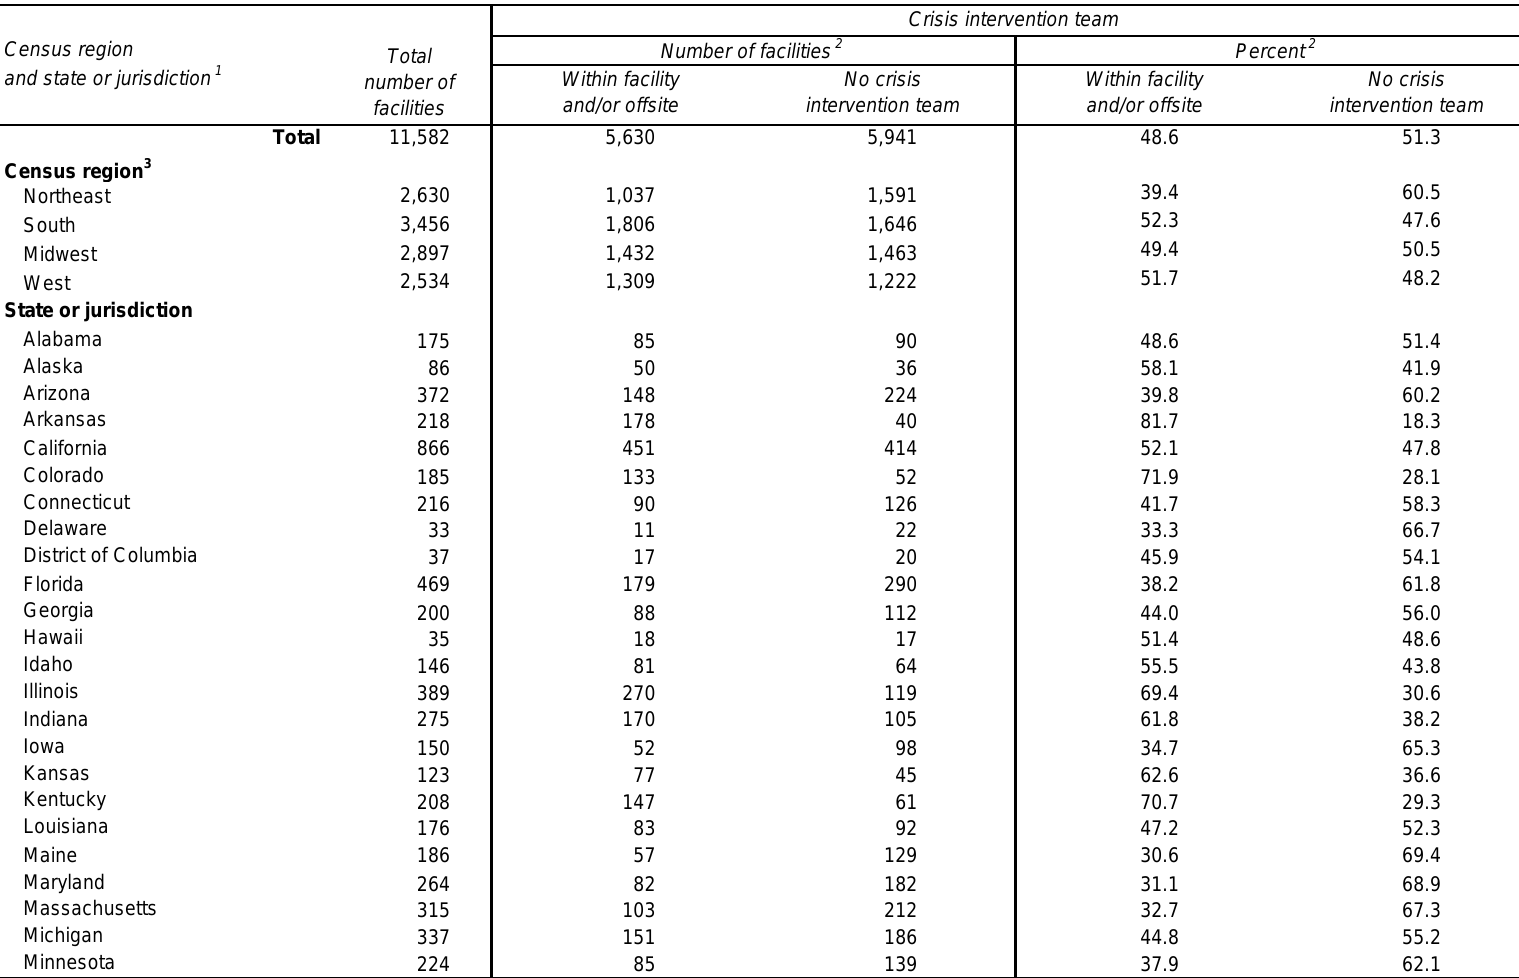
Table 3.12. Mental health treatment facilities that employ a crisis intervention team, by Census region and state or jurisdiction: Number and percent,